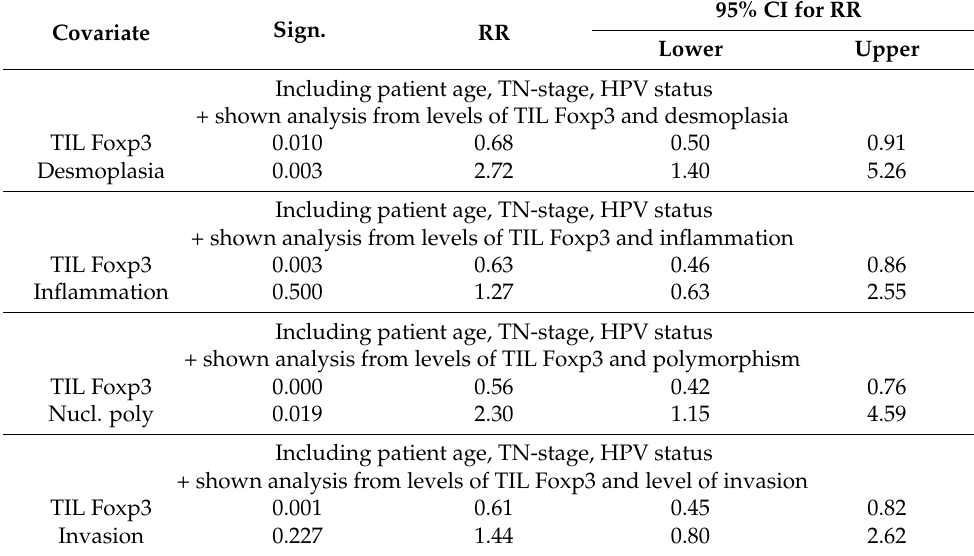
Table 5. Cox multivariate regression five-year DSS analyses including age of patient at diagnosis, TN stage, tumor-HPV status, and epithelial levels of Foxp3-positive cells and whether HE histology generated levels of desmoplasia, inflammation, nuclear ploidity, or invasion.